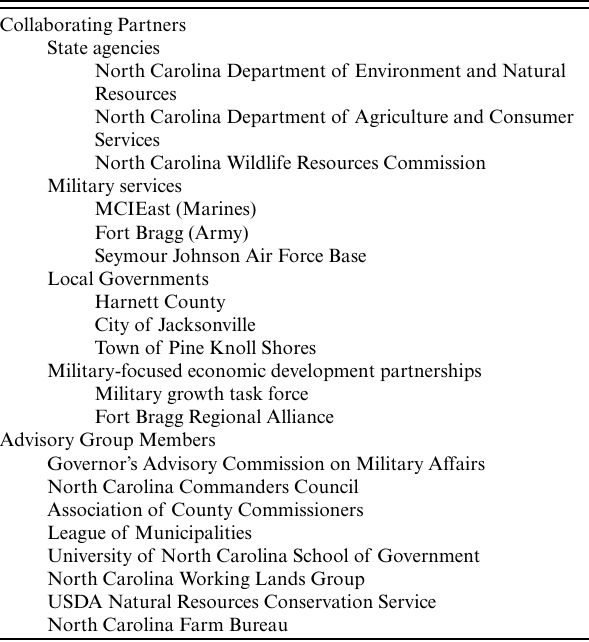
Table 4 . Organizations that were formal members of the Governor’s Land Compatibility Task Force